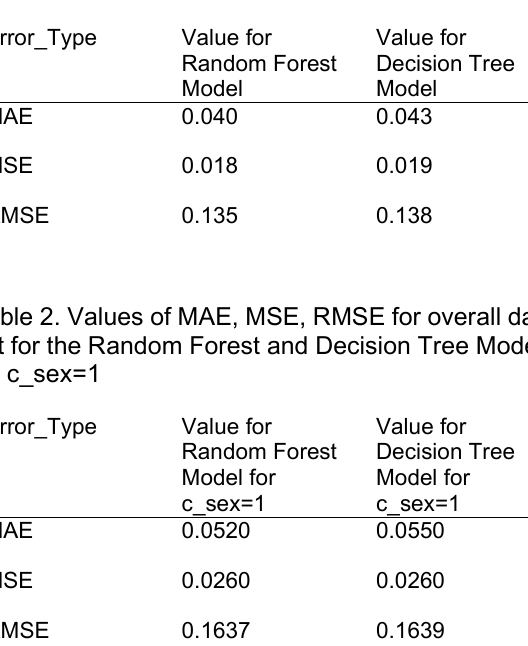
Table 1. Values of MAE, MSE, RMSE for overall data